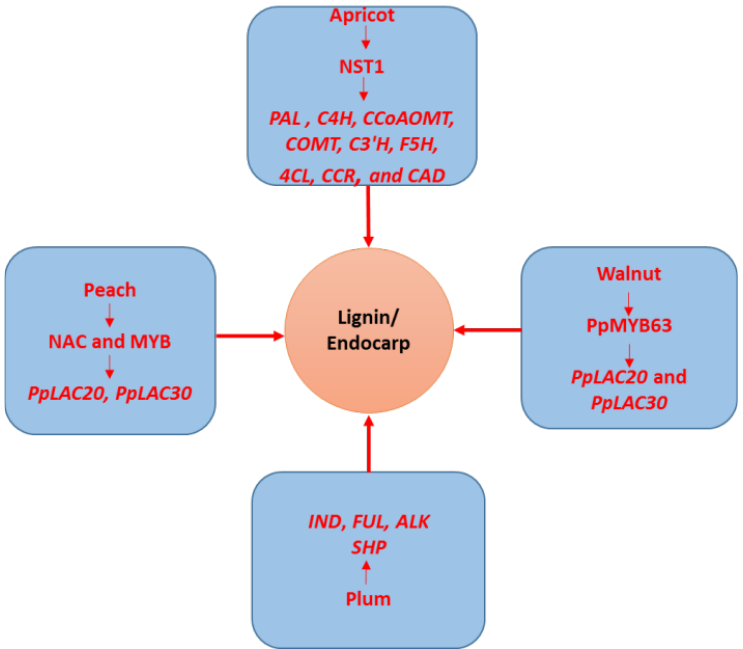
Figure 2. Role of different genes in lignin biosynthesis/endocarp development in fruits. Apricot, peach, plum, and walnut are taken as an example. The NST1 regulates the expression of PAL, C4H, CCoAOMT, COMT, C3’H, F5H, 4CL, CCR, and CAD genes resulting in endocarp formation. The TFs NAC and MYB activate the expression of PpLAC20, and PpLAC30 in peach resulting in endocarp lignification. Similarly, in plum fruit, IND, FUL, ALK, and SHP regulate the production of stone/endocarp, while PpMYB63 activates the expression of PpLAC20 and PpLAC30 genes regulating endocarp